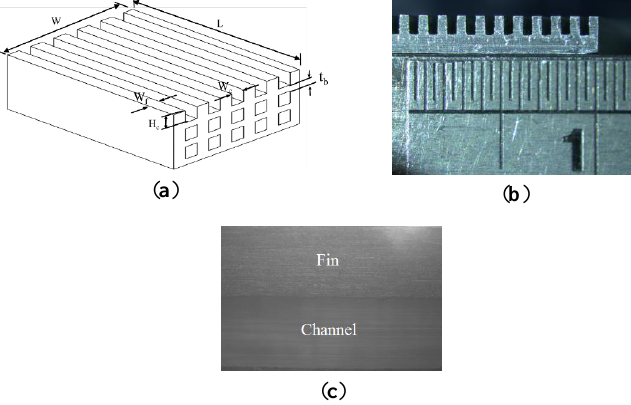
Figure 3. ( a ) Concentrating photovoltaic (CPV) assembly for Azurspace 3C44A; ( b ) CPV assembly layers.